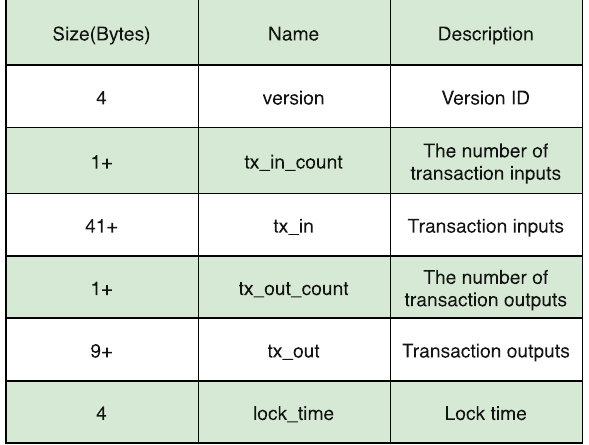
Fig. 1 Transaction structure of Bitcoin